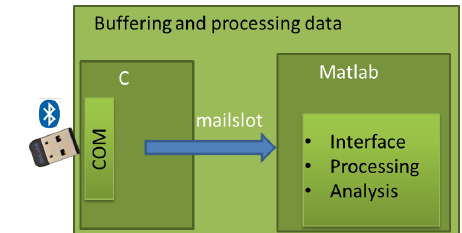
Figure 18. PC scheme.